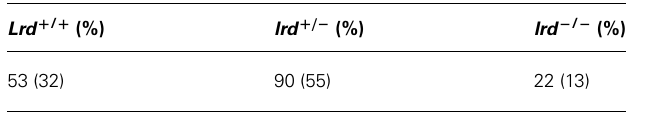
Table 1 | Observed rates of allele frequencies: Lrd-Neo-GFP allele, lrd + / − × lrd + / − .